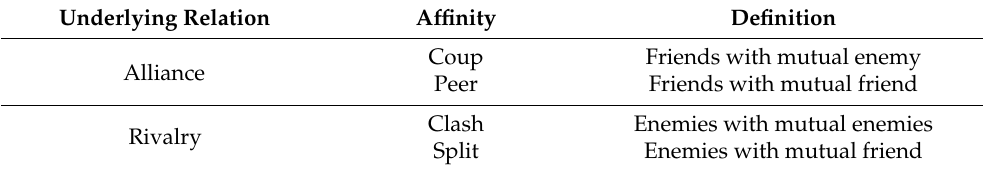
Table 1. Underlying Relations and Potential Affinities for Organized Fan